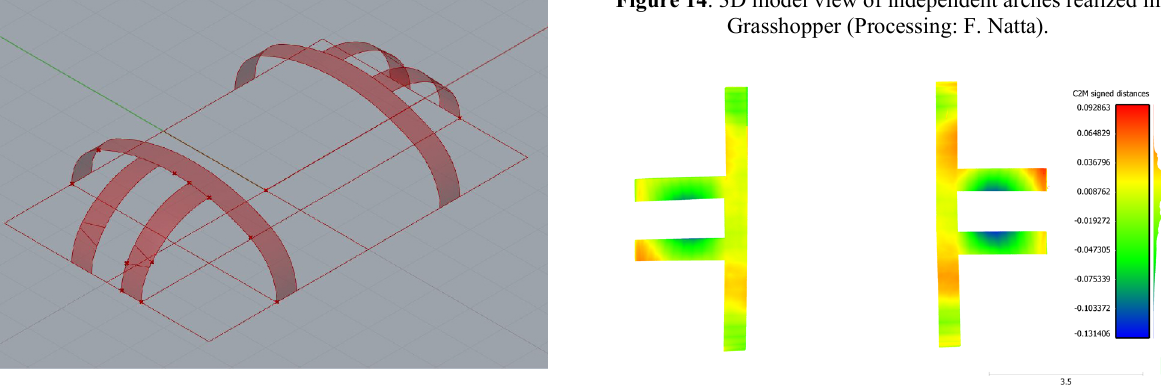
Figure 13 . 3D model view of independent arches realized in Grasshopper (Processing: F. Natta).